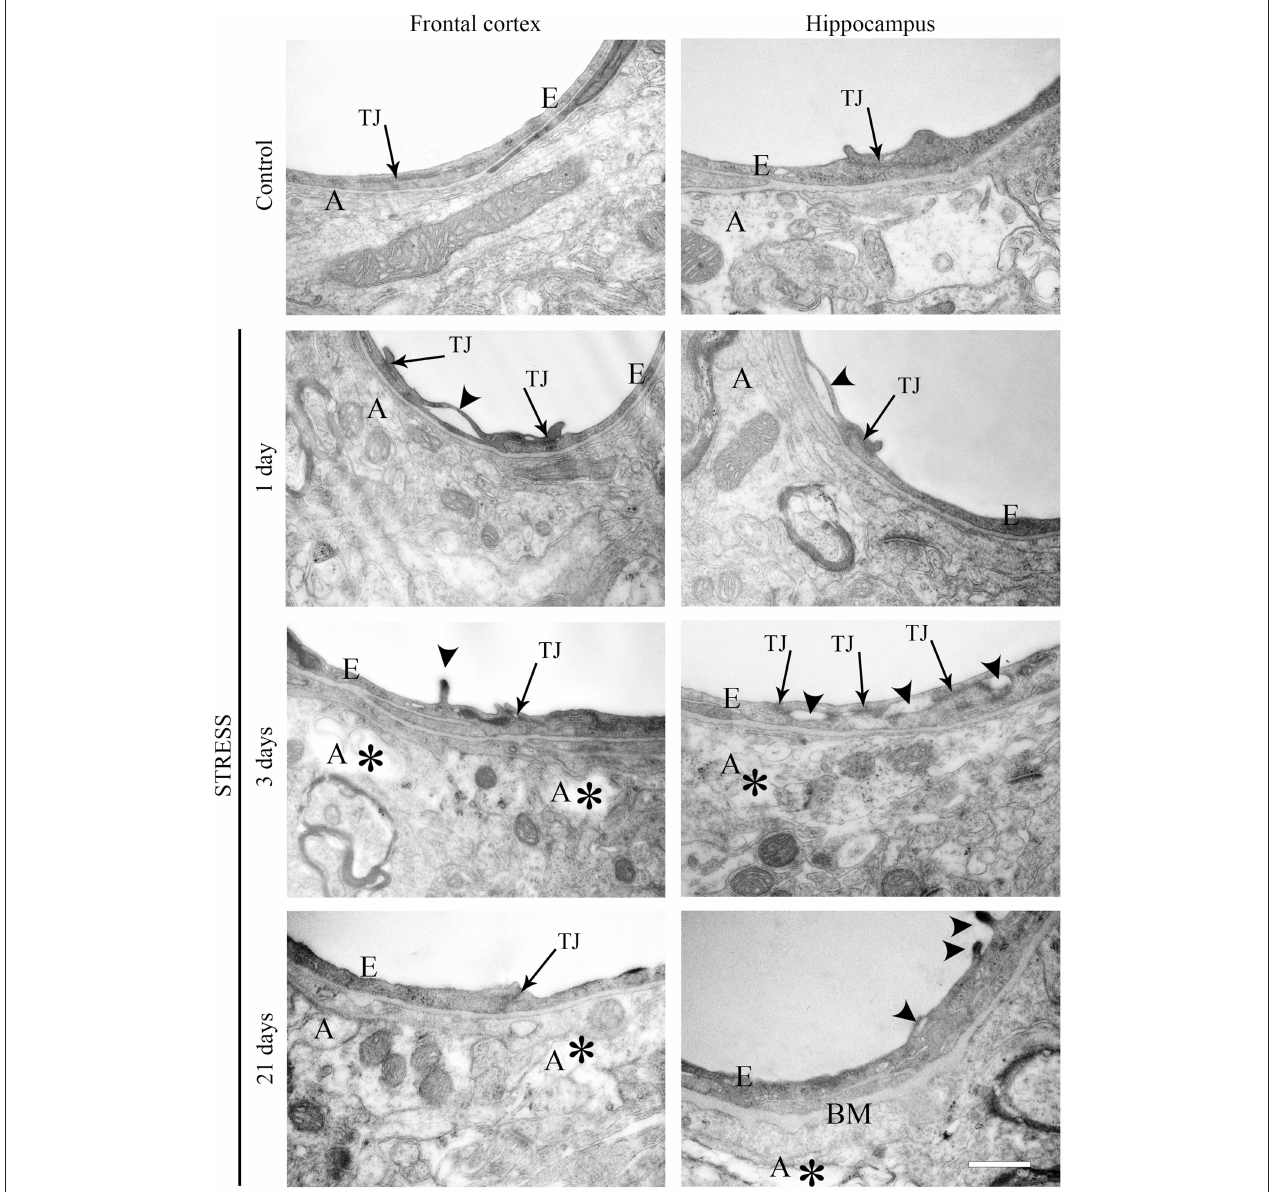
FIGURE 12 | Electron micrographs of brain capillaries in the frontal cortex and hippocampus of control and stressed rats. E, brain endothelial cell; A, astrocyte; TJ, tight junction; BM, basal membrane; arrows indicate tight junctions; arrowheads point to brain endothelial deformities; asterisk marks edema in astrocytes. Scale bar: